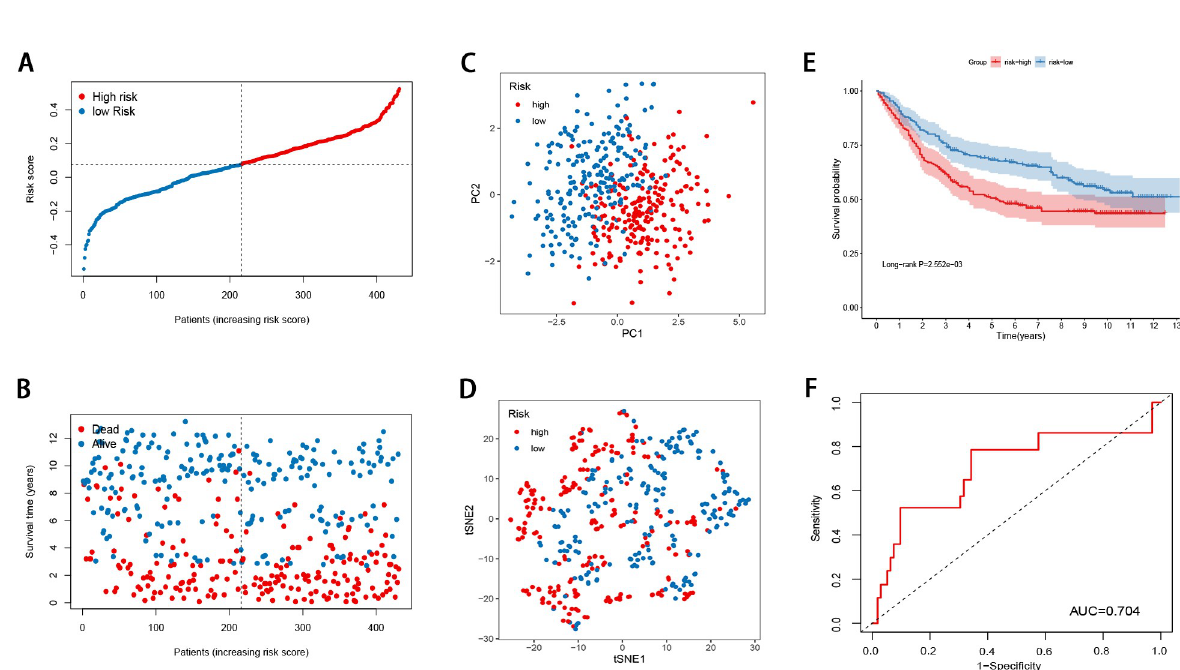
Fig 3. Validation of the ferroptosis-related gene signature in the validation cohort (A) The risk score distribution (B) Overall survival time of GC patients (C) PCA plot (D) t-SNE analysis (E) Kaplan-Meier curves for the OS of patients in the high-risk group and low-risk group (F) ROC curve for the prediction of GC